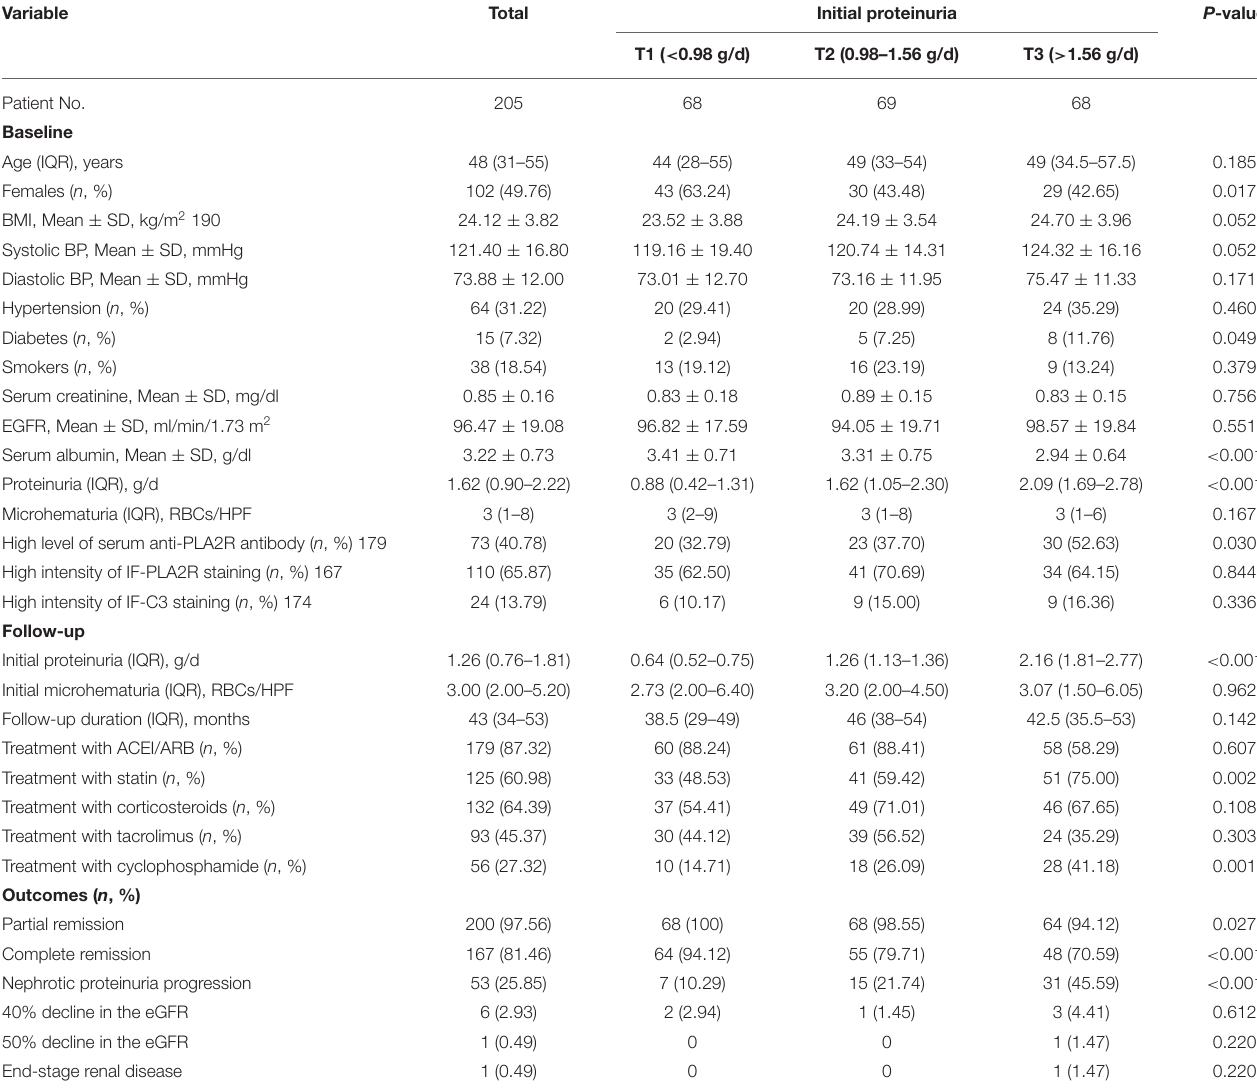
TABLE 1 | Clinical characteristics according to the tertiles of the initial proteinuria. Variable